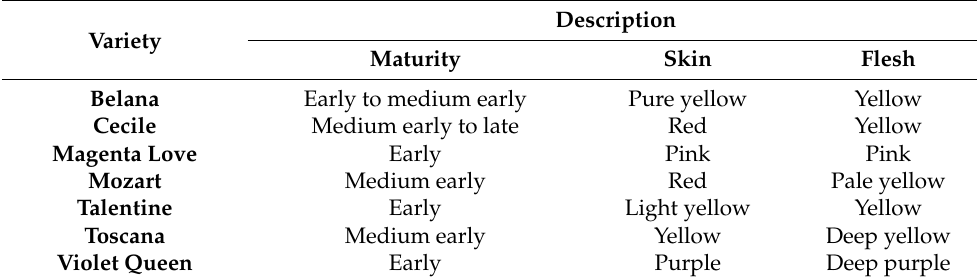
Table 1. Characteristics of potato varieties. Description Variety Maturity Skin Flesh Belana Early to medium early Pure yellow Yellow Cecile Medium early to late Red Yellow Magenta Love Early Pink Pink Mozart Medium early Red Pale yellow Talentine Early Light yellow Yellow Toscana Medium early Yellow Deep yellow Violet Queen Early Purple Deep purple Potato samples were grown in the cadastral area of Majcichov, Slovakia (48 ◦ 17 (cid:48) 00